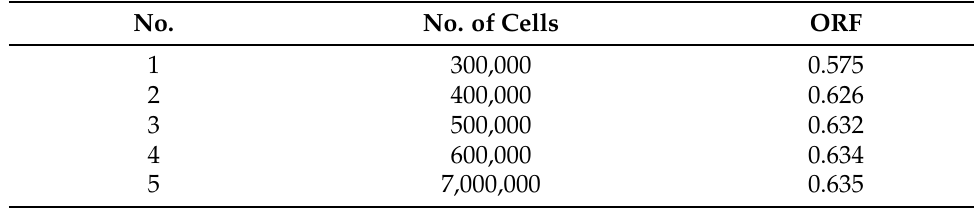
Table 6. ORF at (1 m, 0.5 m, 0.5 m, 200 s) with different grids.